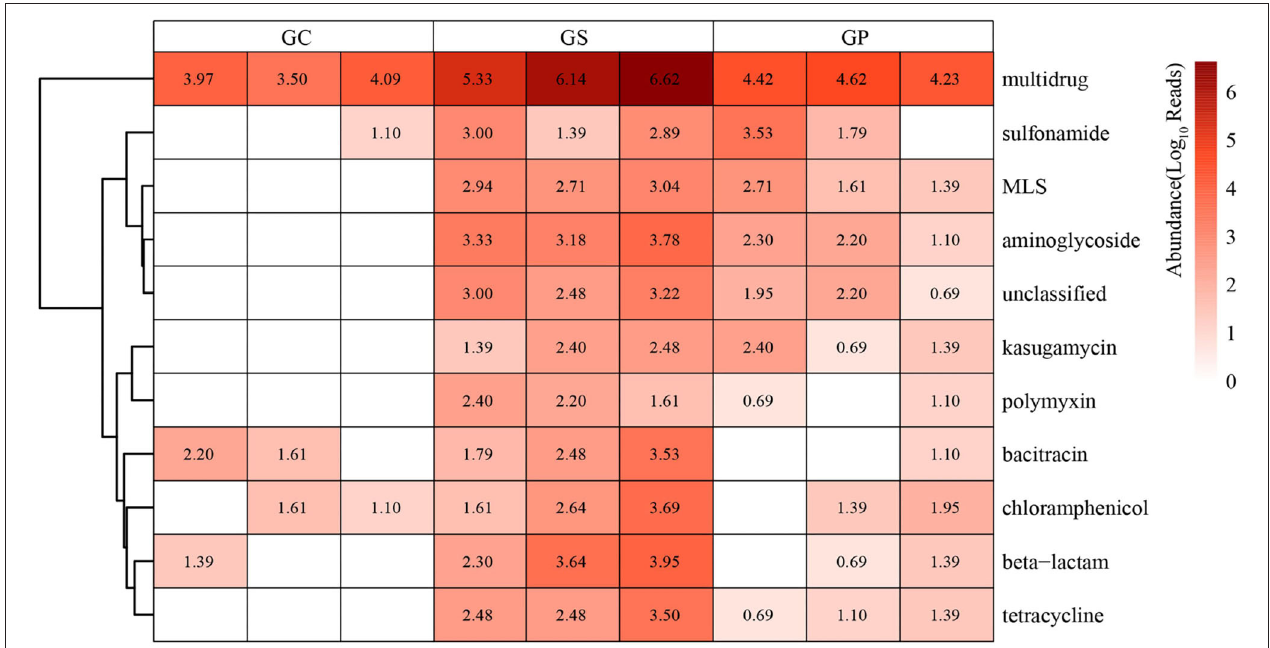
co-occurrence network and had more complex correlations (30 edges) compared with other ARGs. Similarly, multidrug genes occupied 59 (69.4%) of the 85 nodes, of which mdfA-02, mexB- 01, smeE-05, and acrB interacted with more than 25 ARGs, which were the main subtypes of ARGs in the